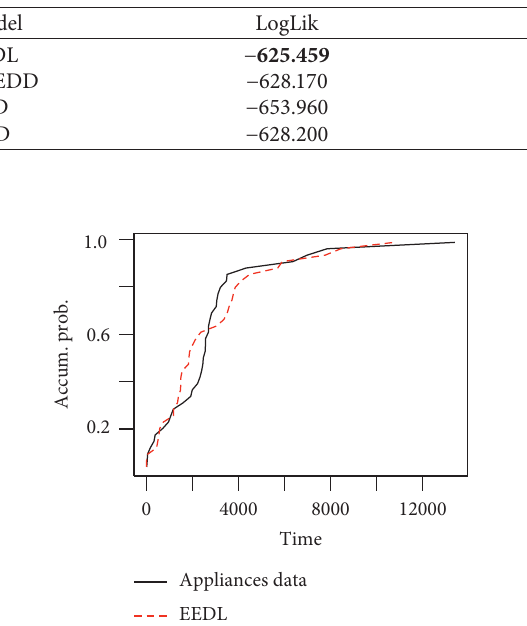
Table 7: Log-likelihood, information, and goodness-of-fit criteria for yarn data.